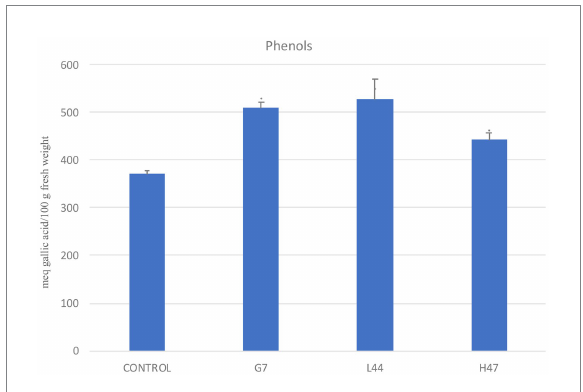
FIGURE 4 Total phenols (meq gallic acid/100 g fresh weight), in olive tree leaves treated with the three strains and non-inoculated controls. For each treatment and parameter average value ± SE value is presented ( n = 6). Asterisks ( * ) represent significant differences with the control according to the T student test ( p <